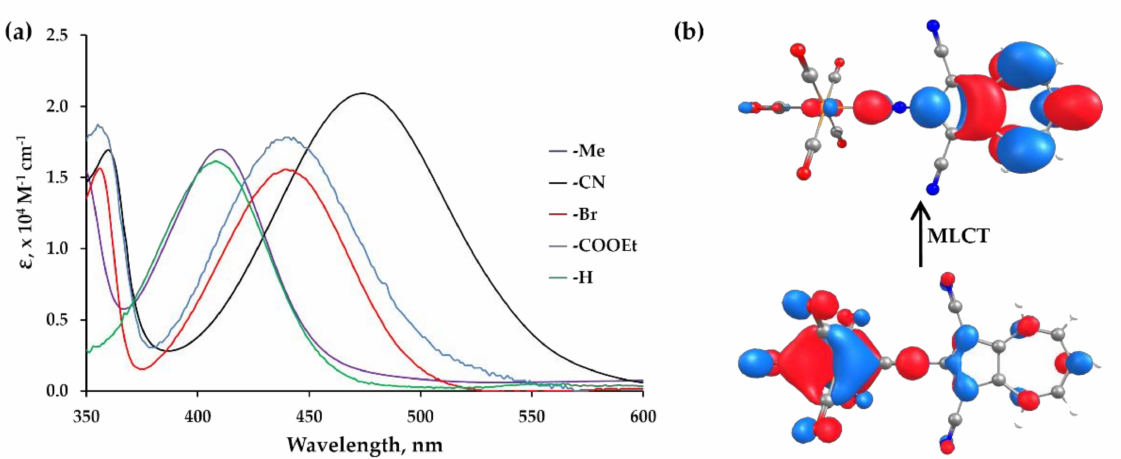
Figure 7. ( a ) Electronic absorption spectra of 6 (green), 7 (purple), 8 (blue), 9 (red), and 10 (black) in CH 2 Cl 2 ; ( b ) DFT- calculated molecular orbitals involved in Cr(d π ) → CNAz(p π *) MLCT for 10